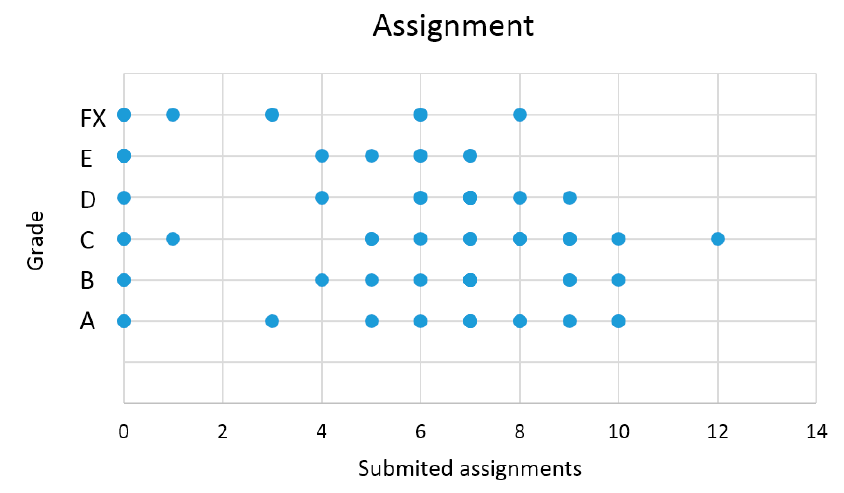
Figure 9. Grades based on visits in “Assignment” material.